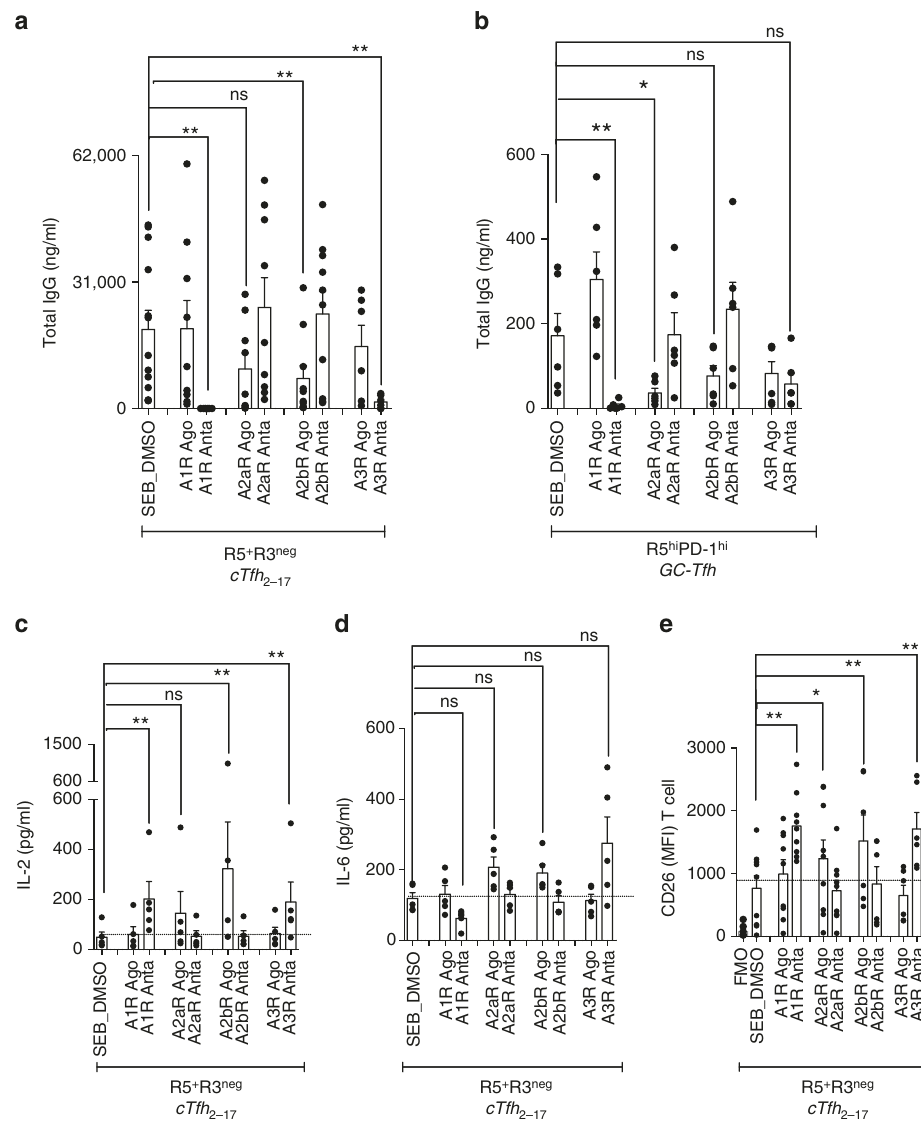
Fig. 4 Adenosine receptor signaling fi ne-tunes Tfh helper program. a Production of IgG in the supernatants of 7-day co-cultures of cTfh 2-17 (CXCR5 + CXCR3 neg ) in the presence of agonists or antagonists of A1R, A2aR, A2bR and A3R ( n = 6 – 10 per group, in four-independent experiments). (ANOVA, paired, two-tailed non-parametric t -test; * p < 0.05, ** p < 0.01; Mean ± SEM). b Production of IgG in the supernatants of 5-day co-culture of GC-Tfh in the presence of agonists or antagonists of A1R, A2aR, A2bR and A3R ( n = 6 per group, in two-independent experiments). (ANOVA, paired, two- tailed non-parametric t -test * p < 0.05, ** p < 0.01; Mean ± SEM). c , d IL-2 and IL-6 production in the supernatants of 7-day co-culture of cTfh 2-17 (CXCR5 + CXCR3 neg ) in the presence of agonists or antagonists of A1R, A2aR, A2bR and A3R ( n = 6 per group, in two-independent experiments) (ANOVA, paired, two-tailed non-parametric t -test; * p < 0.05, ** p < 0.01; Mean ± SEM). e Extracellular CD26 expression by of 7-day co-culture of cTfh 2-17 (CXCR5 + CXCR3 neg ) in the presence of agonists or antagonists of A1R, A2aR, A2bR and A3R ( n = 6 – 9 per group, in 2 – 3-independent experiments) (ANOVA, paired, two-tailed non-parametric t -test; * p < 0.05, ** p < 0.01; Mean±